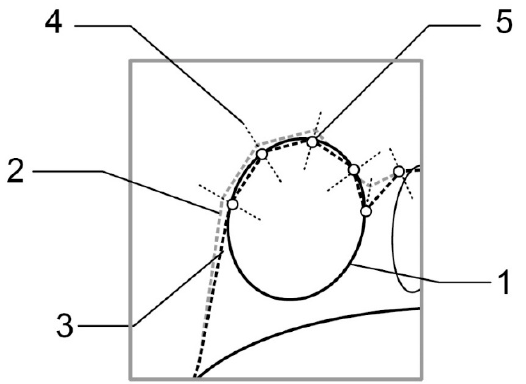
rigid transformation; (3) foot template transformed with non-rigid transformation; (4) bisection lines; (5) optimal foot template point.